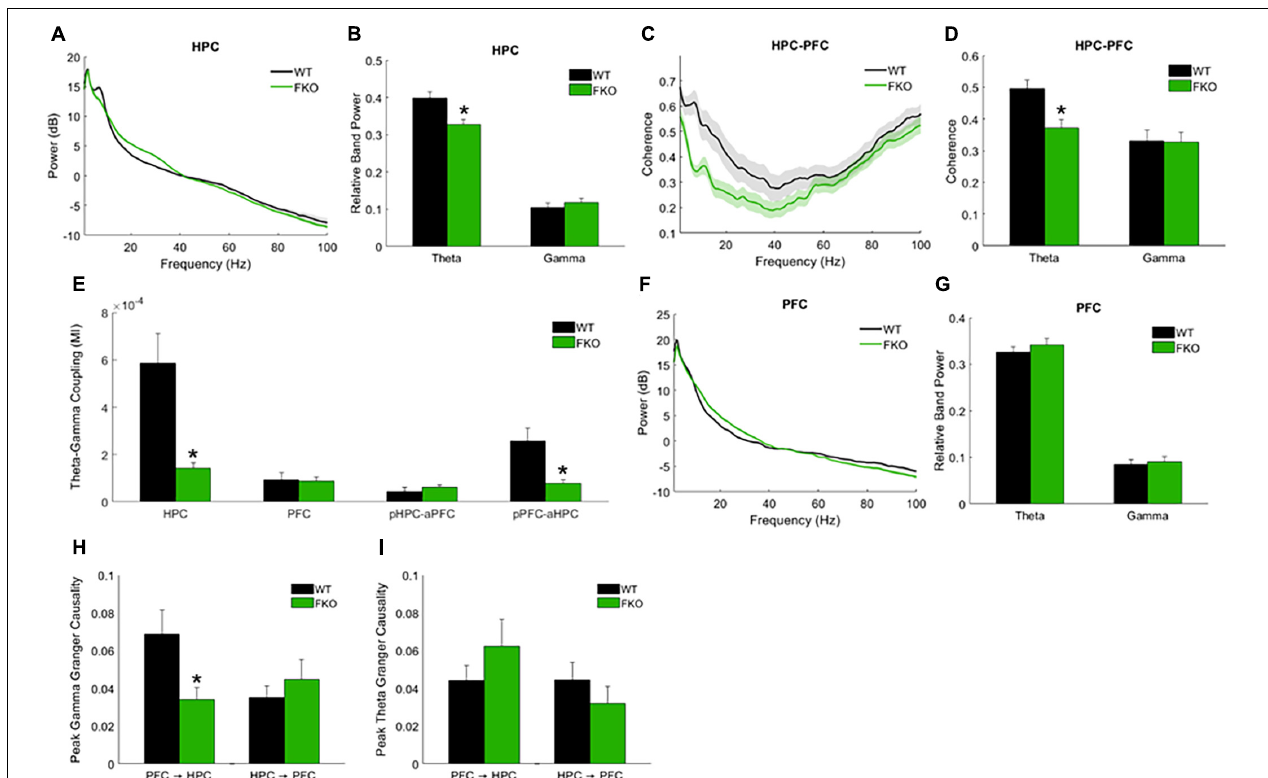
FIGURE 2 | Resting-state neural oscillations in WT ( n = 16) and 14-3-3 FKO mice ( n = 19). HPC power spectra (A) and band power (B) measurements show that theta power is decreased in FKO mice. FKO mice exhibit decreased theta coherence between the HPC and PFC (C,D) . Theta-gamma coupling within the HPC and inter-regional coupling between PFC phase and HPC amplitude is decreased in FKO mice (E) , while coupling between HPC phase and PFC amplitude is not statistically different between FKO and WT mice. There are no statistically signifcant differences in the PFC theta or gamma power (F,G) . In the gamma frequency range, FKO oscillations exhibit reduced granger causality in the PFC to HPC direction, but not the reverse (H) . There are no differences in theta granger causality between WT and FKO oscillations in either direction (I) . Statistical significance denoted as * p < 0.05. MI, modulation index. pHPC, HPC phase. aPFC, PFC amplitude. pPFC, PFC phase. aHPC, HPC